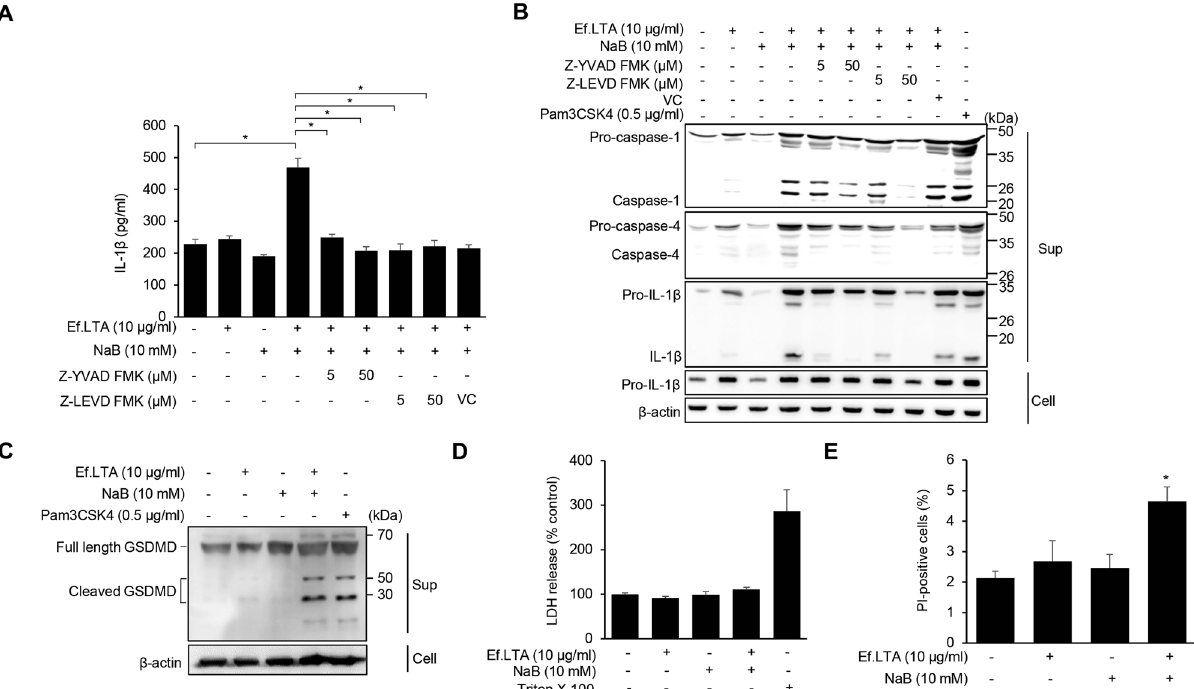
Fig. 6 Activation of both caspase-1 and caspase-4 is required for Ef.LTA/NaB-induced in fl ammasome activation. A PMA-differentiated THP-1 cells were pre-treated with the indicated concentrations of the caspase-1 inhibitor (Z-YVAD-FMK), the caspase-4 inhibitor (Z-LEVD-FMK), for 1 h and subsequently co-stimulated with Ef.LTA (10 μ g/ml) and NaB (10 mM) for an additional 6 h. IL-1 β expression in the culture supernatants was measured by ELISA. B Pro- or active caspase-1 and IL-1 β in the culture supernatants (Sup) and pro-IL-1 β and β -actin in the cell lysates (Cell) were detected by immunoblotting. Pam3CSK4 was used as a positive control. C The cells were co-stimulated with Ef.LTA (10 μ g/ml) and NaB (10 mM) for 6 h. Then, the culture supernatants were collected and the level of cleaved GSDMD was determined by immunoblotting. D The cells were co-stimulated with Ef.LTA (10 μ g/ml) and NaB (10 mM) for 24 h. The LDH in culture supernatants was measured using the LDH-cytotoxicity colorimetric assay kit. E The cells were co-stimulated with Ef.LTA (10 μ g/ml) and NaB (10 mM) for 6 h and stained with PI. The images were captured under a microscope and PI-positive cells were counted by ImageJ software. VC denotes vehicle control (DMSO). The results shown are representative of triplicate experiments. All results are expressed as mean ± SD of triplicate samples. * p < 0.05. L. plantarum LTA attenuates Pam2CSK4 and Poly I:C-induced IL-8 chain in LTA are different for each bacterial species [47, 48]. LTAs production in intestinal epithelial cells [27, 51]. The acyl group of S. from S. aureus and S. pneumoniae induce in fl ammatory responses aureus LTA and L. rhamnosus GG LTA contains saturated and through the production of nitric oxide and IL-6 [49, 50]. However, unsaturated fatty acid, respectively [48]. We also observed in the Lactobacilli LTAs have anti-in fl ammatory properties. For instance,